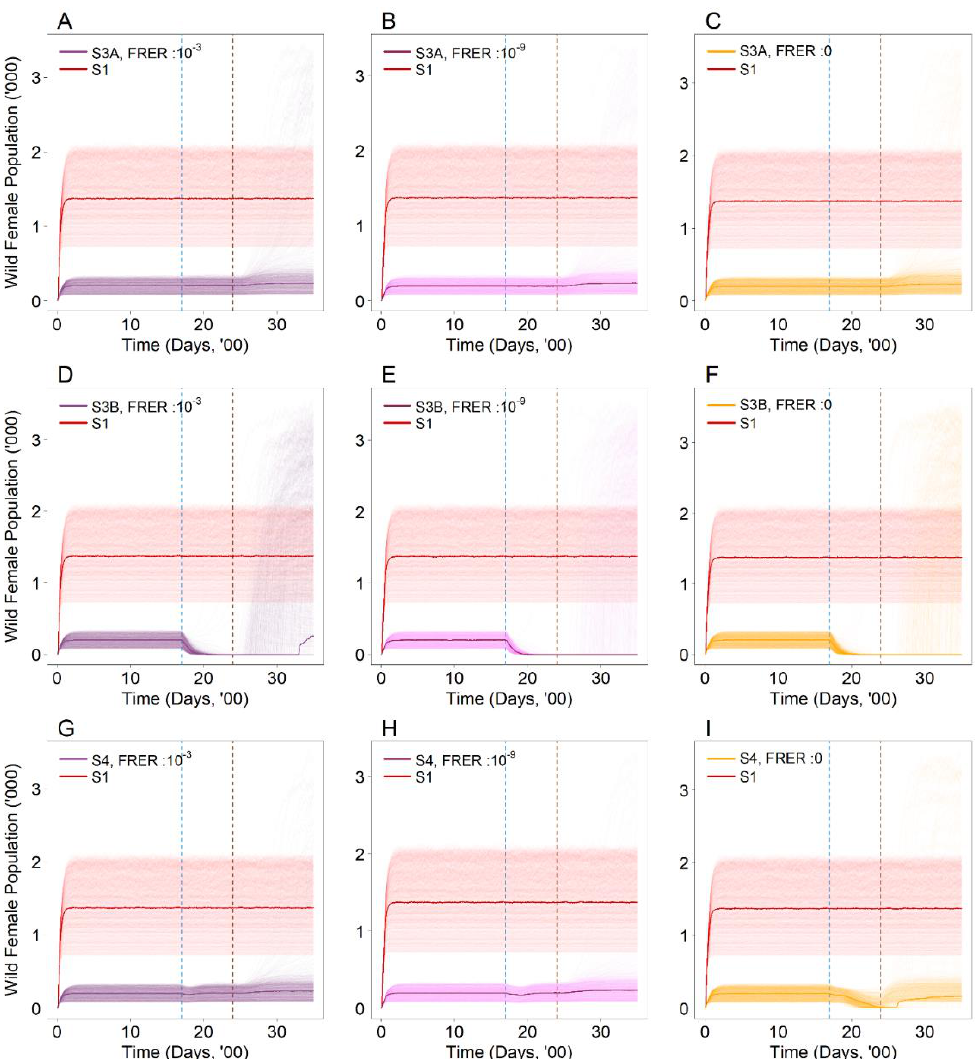
Figure 3. Number of wild type female mosquitoes in the population with ( A ) FRER: 10 − 3 , ( B ) FRER: 10 − 9 and ( C ) FRER: 0 under the first strain female irradiation (S3A) with the same male release intensity. Number of wild type female mosquitoes in the population with ( D ) FRER: 10 − 3 , ( E ) FRER: 10 − 9 and ( F ) FRER: 0 under the first strain male and female irradiation (S3B) with the same male release intensity. Number of wild type female mosquitoes in the population with ( G ) FRER: 10 − 3 , ( H ) FRER: 10 − 9 and ( I ) FRER: 0 under the second strain introduction (S4) with the same male release intensity. The lighter shade solid lines represent the 1000 simulations, and the dark solid lines represent the median of the 1000 simulations. The blue and brown dotted vertical line represents the start and end of the intervention (S3A, S3B and S4) respectively. The red solid line represents the baseline scenario (S1).